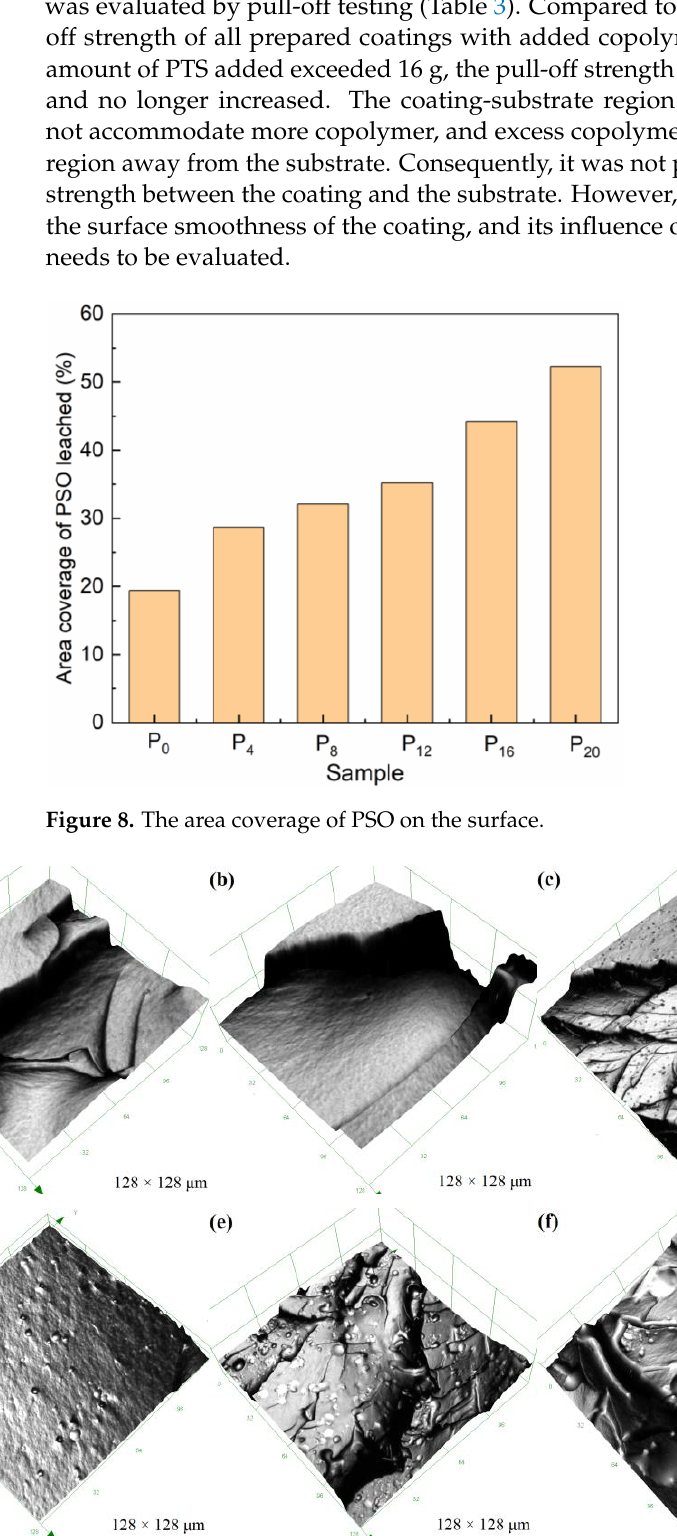
Figure 9. The fracture micro-morphologies of the prepared coatings, which were used to analyze the leaching behavior of PSO: ( a ) P 0 ; ( b ) P 4 ; ( c ) P 8 ; ( d ) P 12 ; ( e ) P 16 ; and ( f ) P 20 .